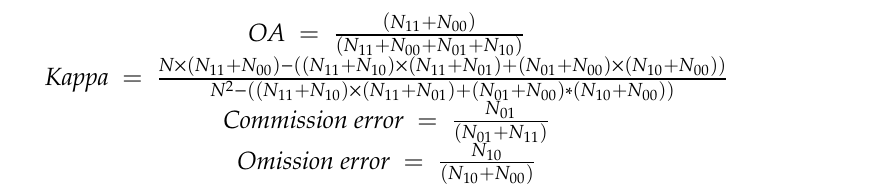
Figure 10. Change detection maps obtained on the third location by: ( a ) Extreme Learning Machine (ELM), ( b ) Support Vector Machine (SVM), ( c ) Multiple Linear Regression (MLR), ( d ) Artificial Neural Network (ANN), ( e ) Deep Convolutional Neural Network (DCNN) ( ω = 9), ( f ) Traditional Siamese Convolutional Neural Network (TSCNN) ( ω = 9), ( g ) Deep Siamese Multi-Scale Convolutional Network (DSMS-CN) ( ω = 9), ( h ) Deep Siamese Convolutional Network Based on Convolutional Feature Extraction Module (OB-DSCNH) ( ω = 9, l = 45), ( i ) Reference map.